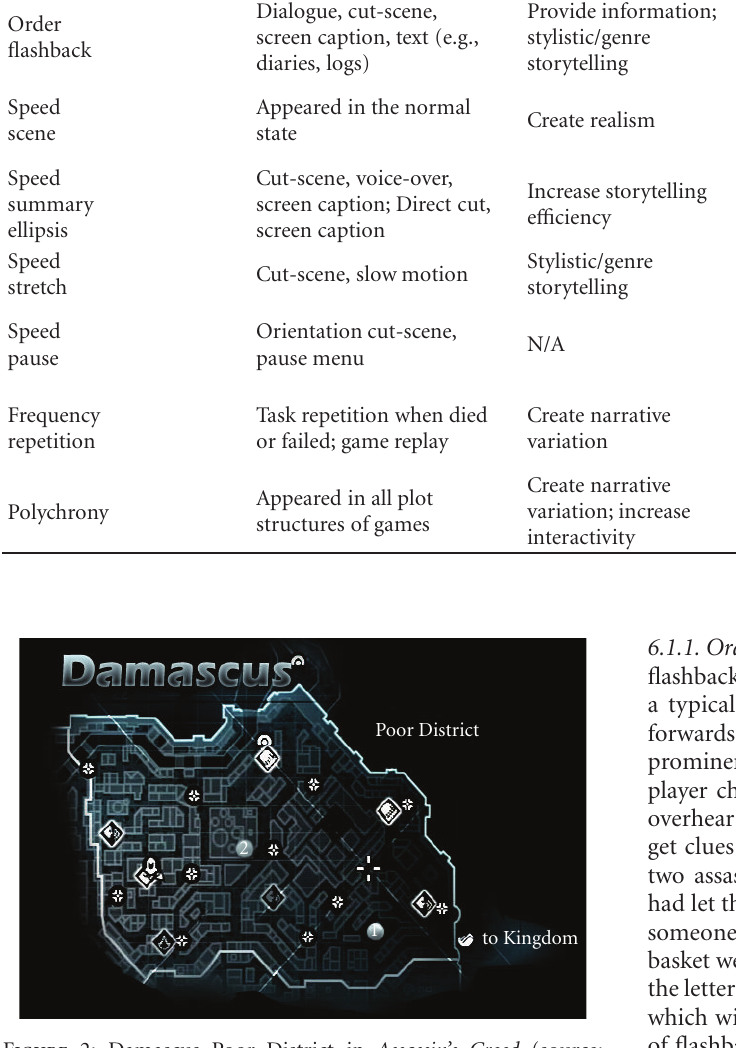
Figure 2: Damascus Poor District in Assassin’s Creed (source: Ubisoft, 2007; image from IGN.com, used with